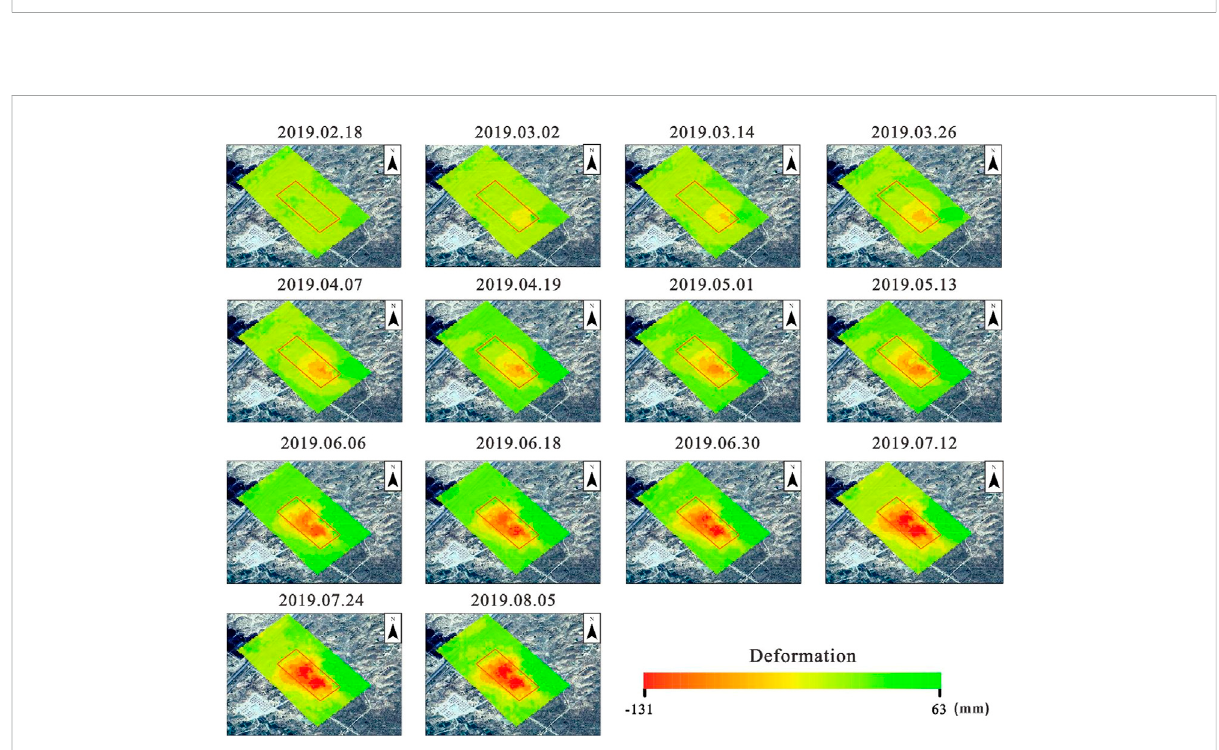
FIGURE 5 Time-series deformation fi eld of the continuous D-InSAR30302 working